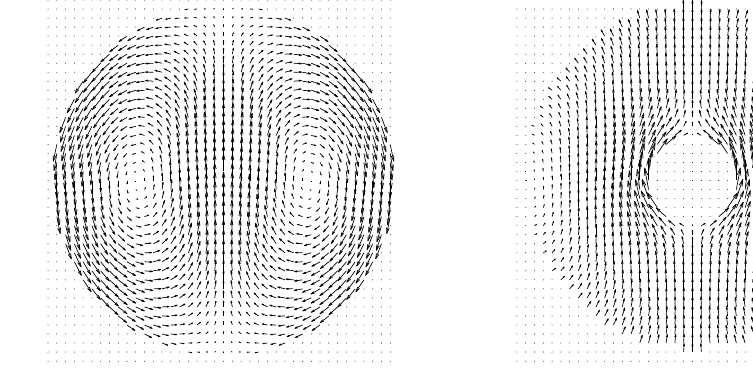
Figure 1. Displacement of the electric field at fixed time obtained from the expression in (2.2) subject to different kinds of boundary constraints. The sizes of the domains are not arbitrary, but strictly related to the frequency of rotation as well as boundary conditions. The magnetic field is orthogonal to the